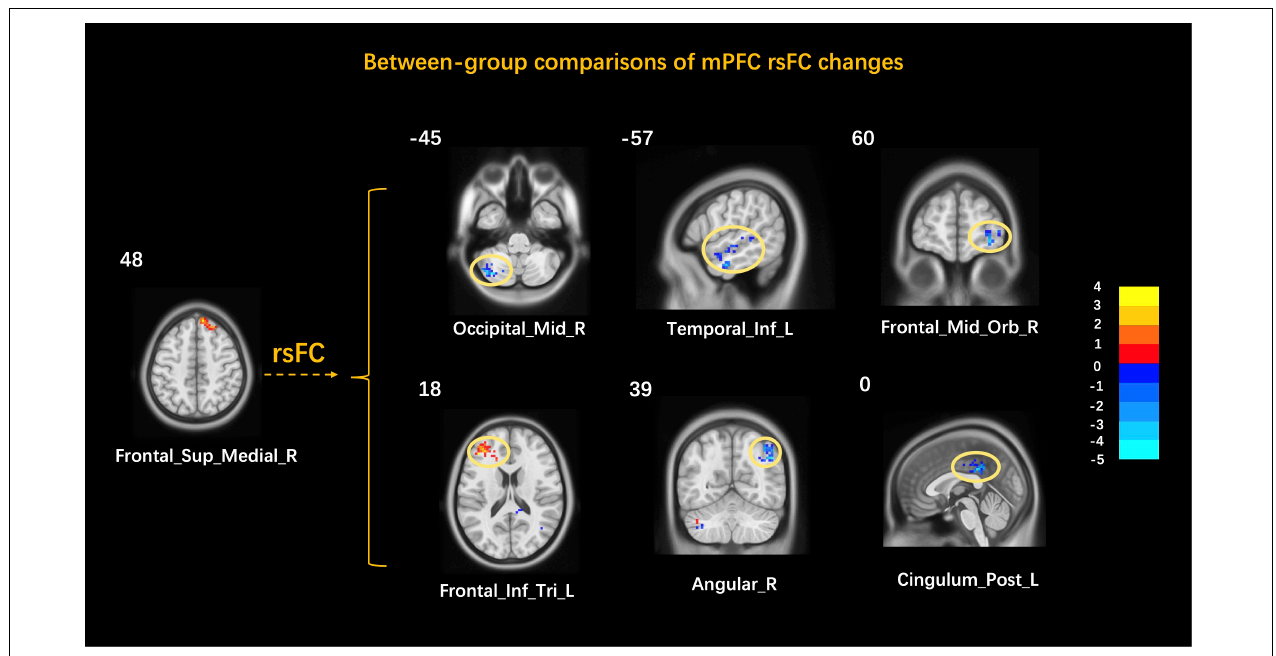
FIGURE 5 | Between-group comparisons of mPFC rsFC changes. MNI, Montreal Neurological Institute; Cerebelum_Crus2, cerebellum inferior; Temporal_Inf, inferior temporal gyrus; Frontal_Mid_Orb, orbital middle frontal gyrus; Frontal_Inf_Tri, inferior frontal gyrus, triangular part; Cingulum_Post, posterior cingulate cortex; L, left; R,